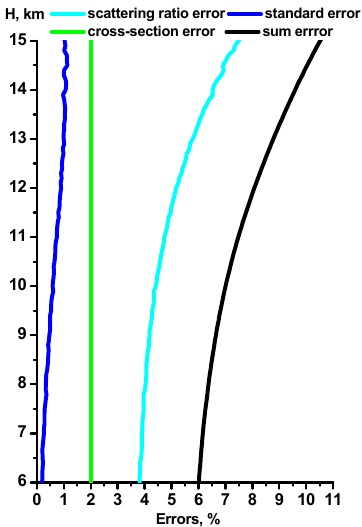
Figure 4. Mean error of ozone profile retrieval over 2015. Figure 5 exemplifies the comparison of lidar and satellite vertical profiles of ozone measured on 26 April 2015; the VDO profiles are compared with the Krueger model [24].